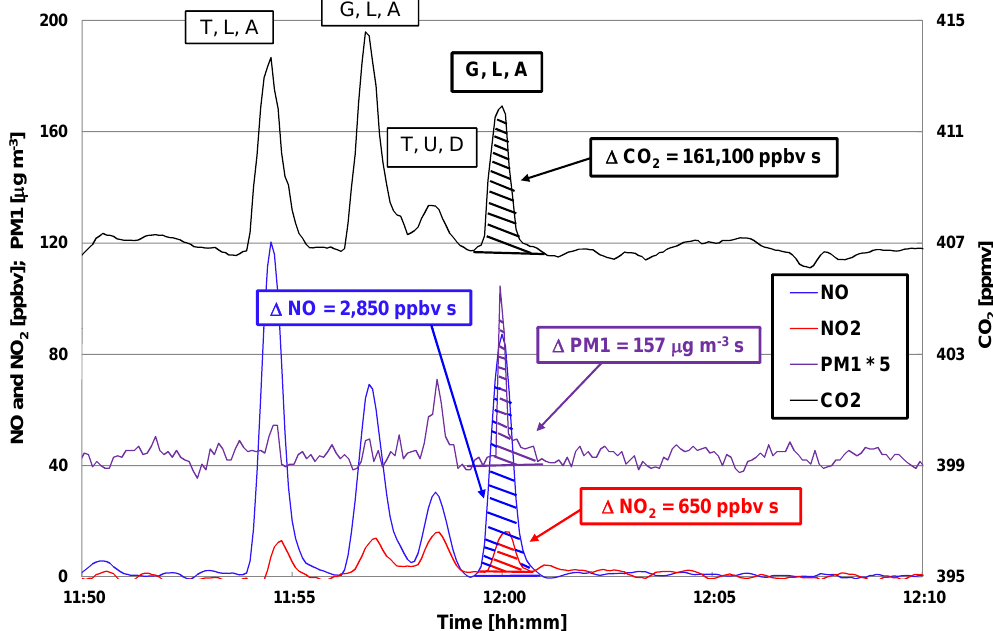
Figure 5. Temporal variation of the NO, NO 2 , CO 2 and PM 1 concentration and the integrated emission peaks at (cid:49) NO, (cid:49) NO 2 , (cid:49) CO 2 and (cid:49) PM 1 peak area at the measurement site on 20 February 2013 from 11:50 to 12:10LT for goods-ship (G) under-loaded (L) and upstream (A)